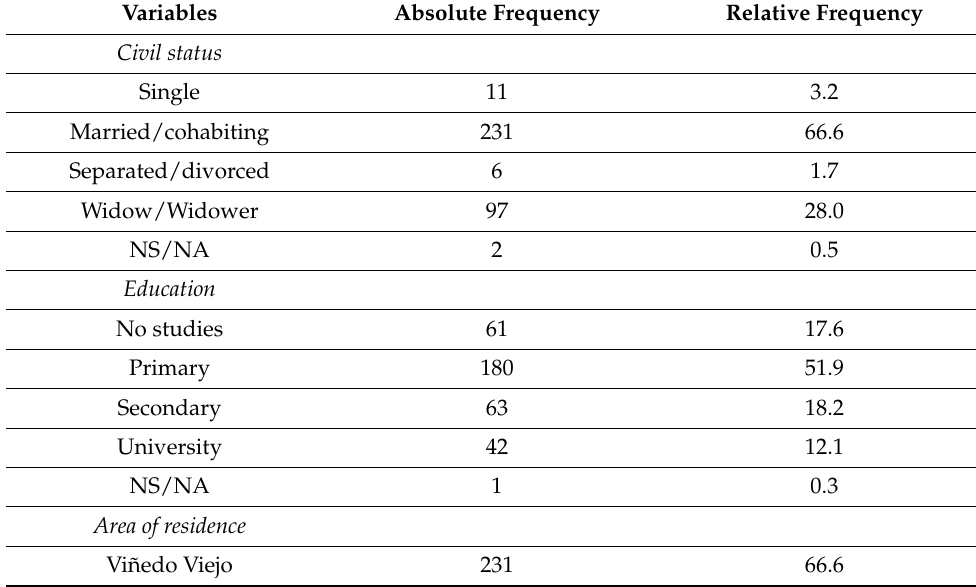
Table 2. General characteristics of